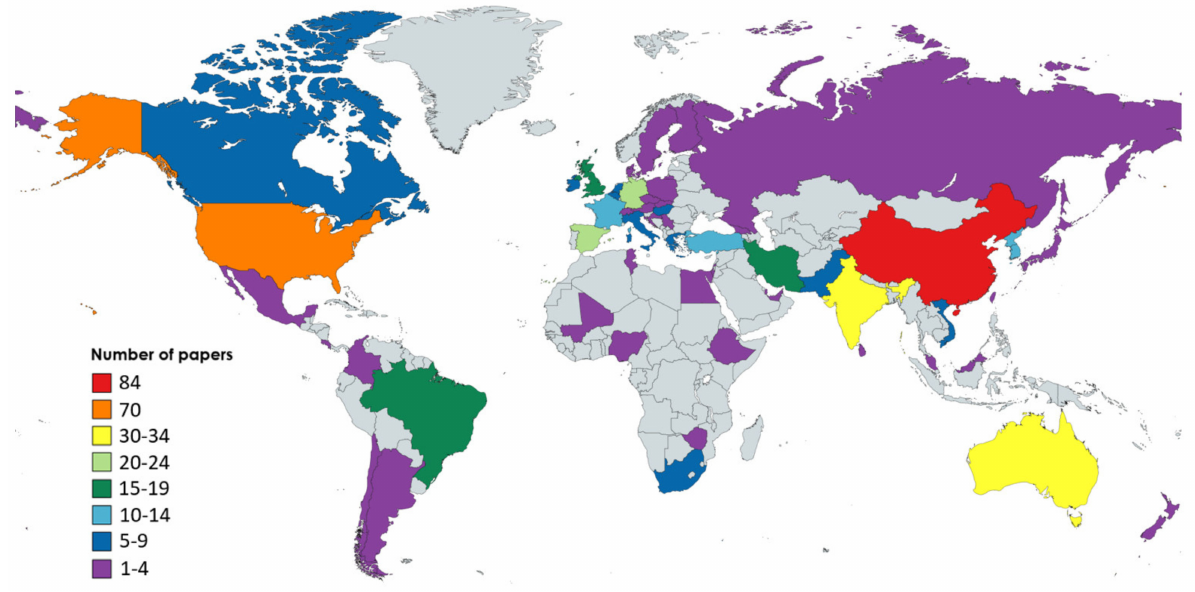
Figure 6. Geographical distribution of the contribution of each country to the research field focusing on machine learning in agriculture.